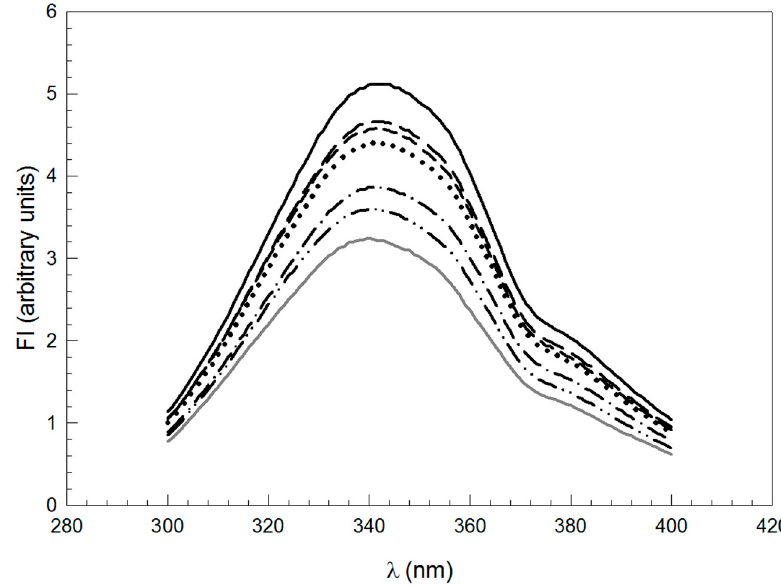
Figure 2. Emission spectra of intrinsic fluorescence (FI) of NaCAS and NaCAS:XG mixtures at different ratios: ( ─ ) without XG; ( ‒ ‒ ) 8:1; (- - -) 6:1; ( ••• ) 4:1; ( ‒ • ‒ ) 2:1; ( ‒ •• ‒ ) 1:1 and ( ─ ) 1:1.5. NaCAS 0.1 wt %, T 35 °C, emission wavelength: λ em = 300–400 nm; excitation wavelength: λ exc = 286 nm.